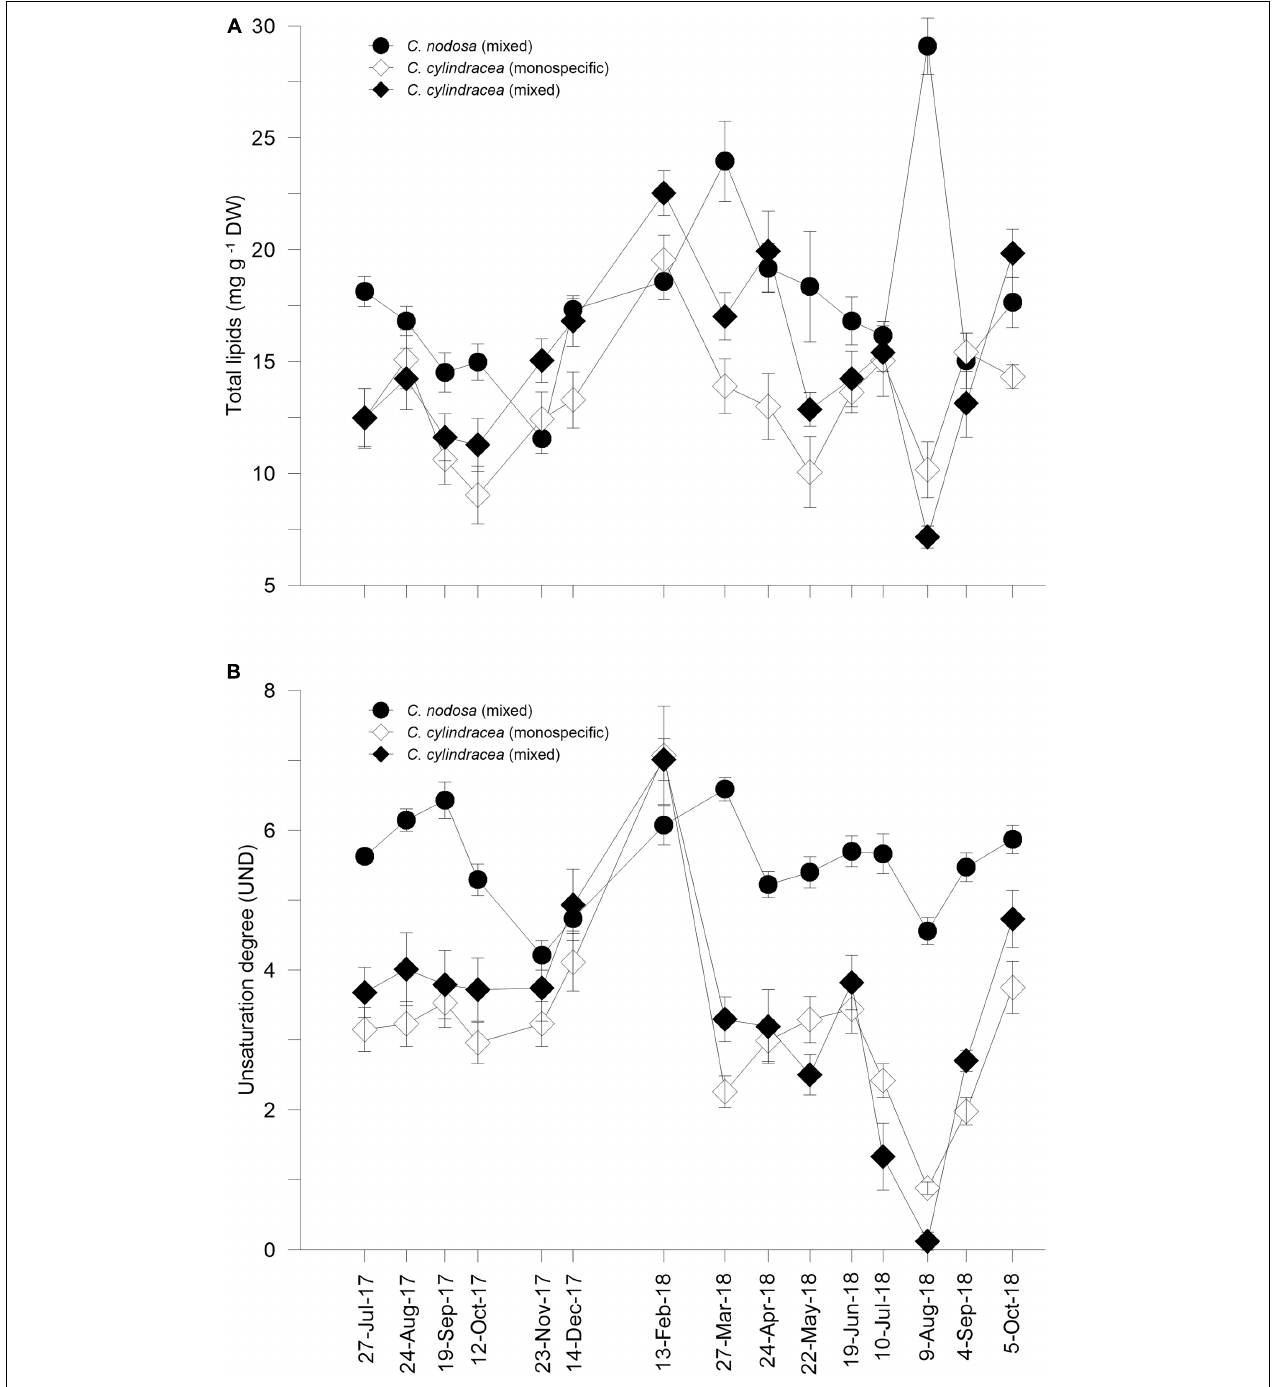
FIGURE 4 | Total lipid concentrations (A) and unsaturation degree (B) in C. nodosa leaves and C. cylindracea thalli in the mixed and monospecific settlement during investigated period. Data are presented as mean ± SD (TL, n = 3; UND, n = 2–3).